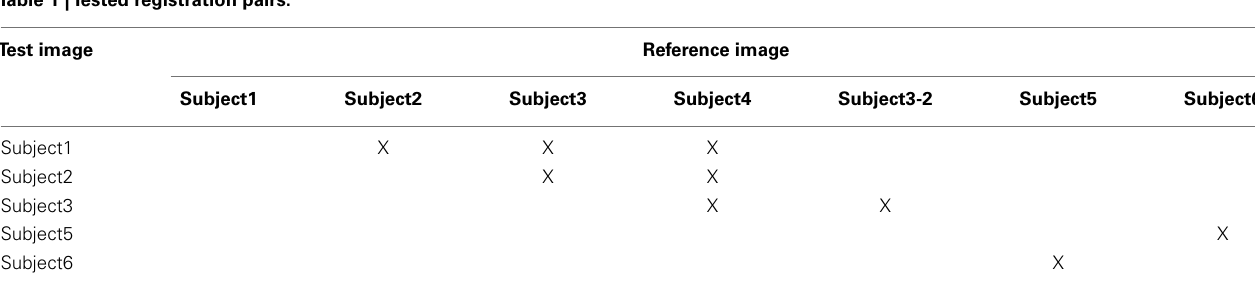
Table 1 |Tested registration